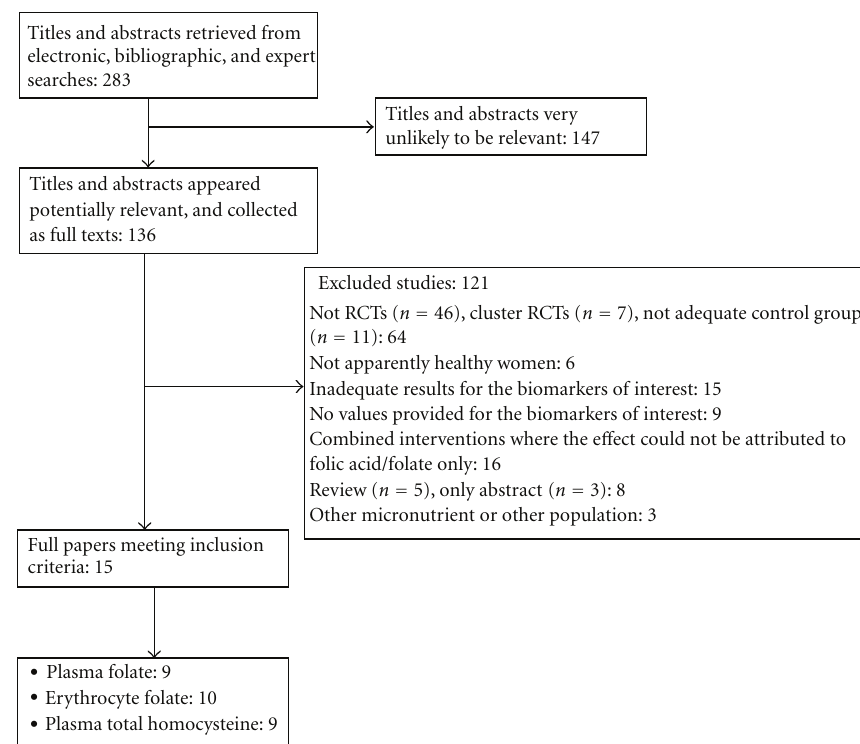
Figure 1: Flow diagram of the articles screened, assessed, and excluded at various stages for this